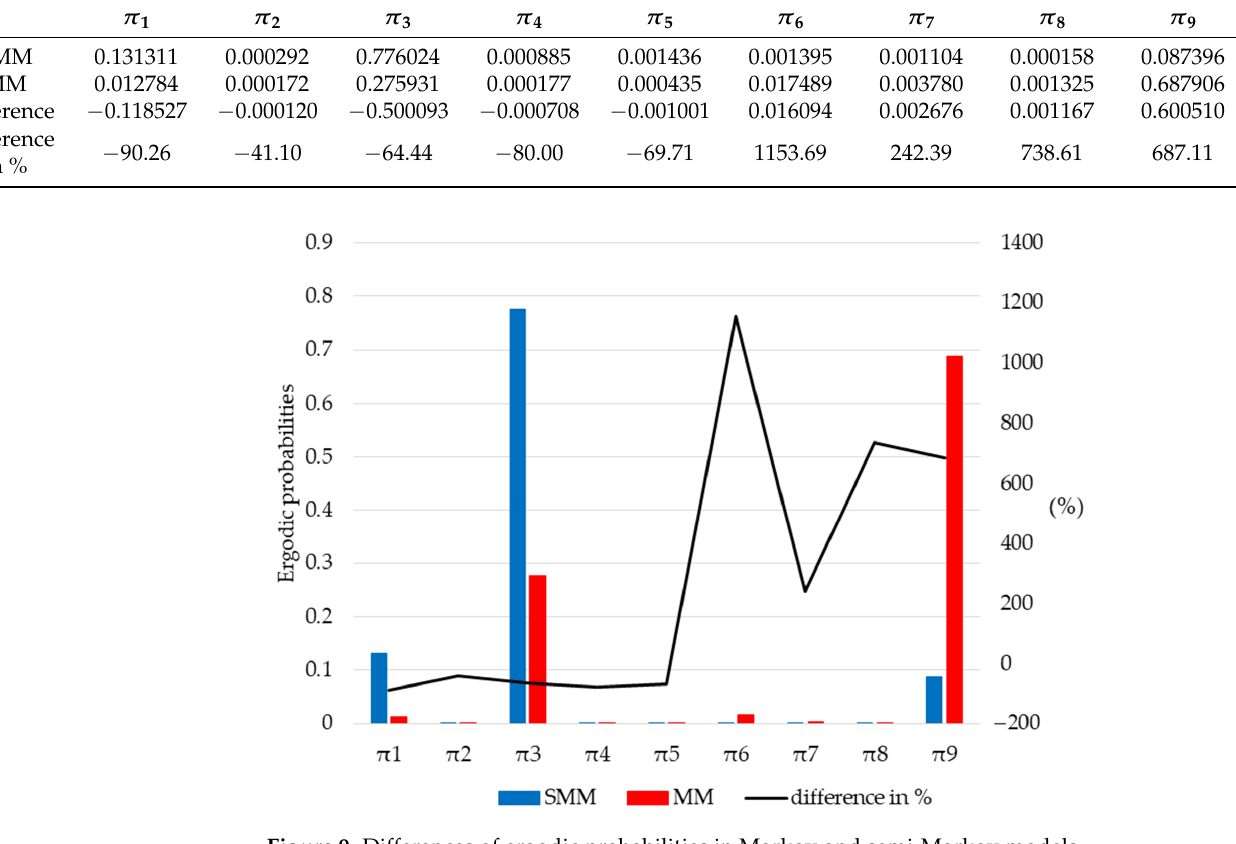
Figure 9. Differences of ergodic probabilities in Markov and semi-Markov models.